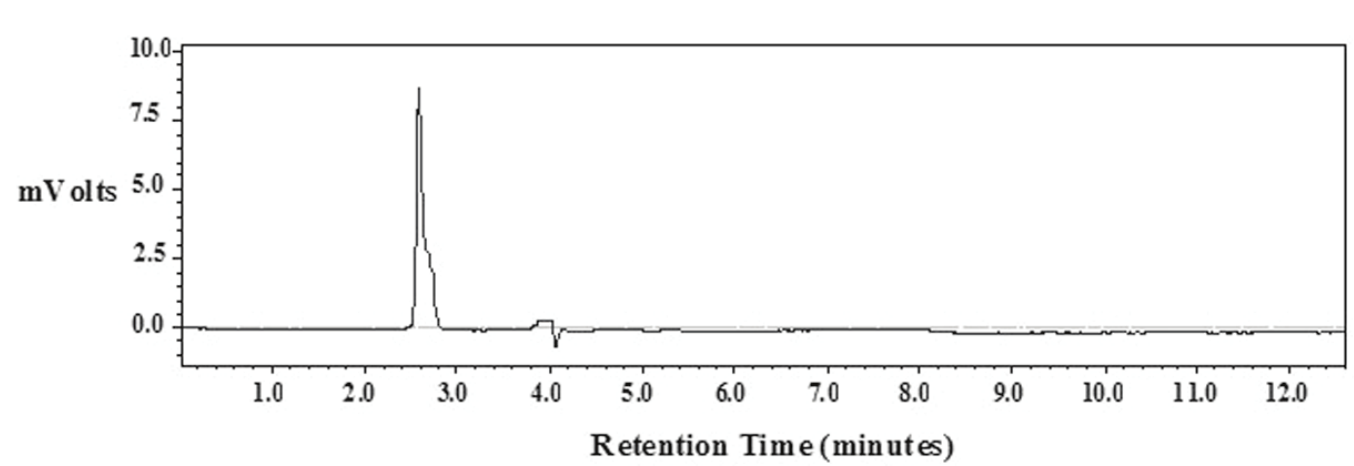
FIGuRE 2 - HPLC chromatogram of